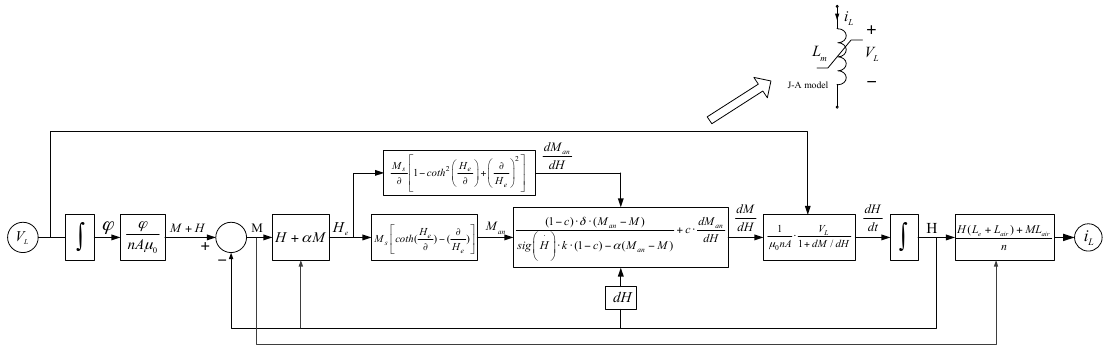
Figure 4. Implementation of the J-A hysteresis model in the PFC converter.